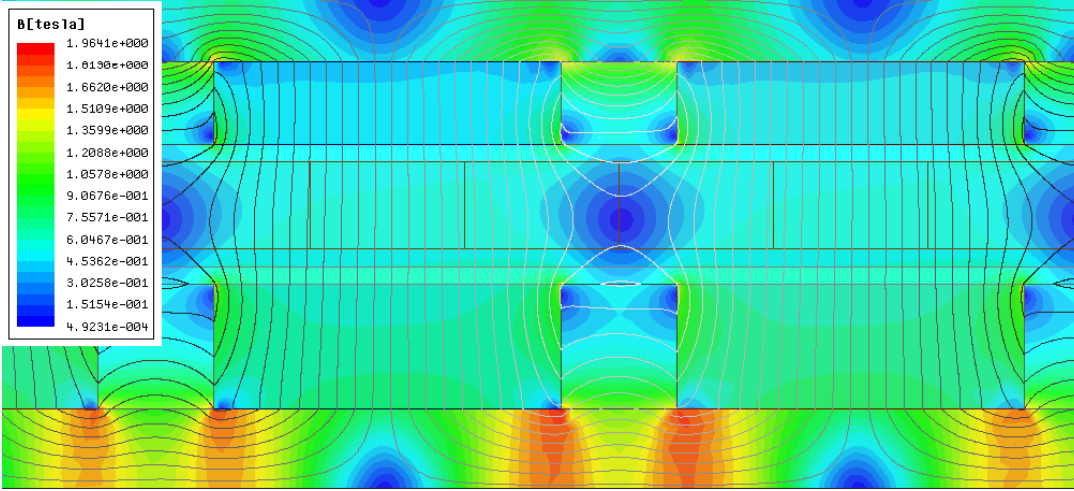
Figure 16. Magnitude of magnetic induction and flux lines of a section of the final actuator design with nominal effective current density.